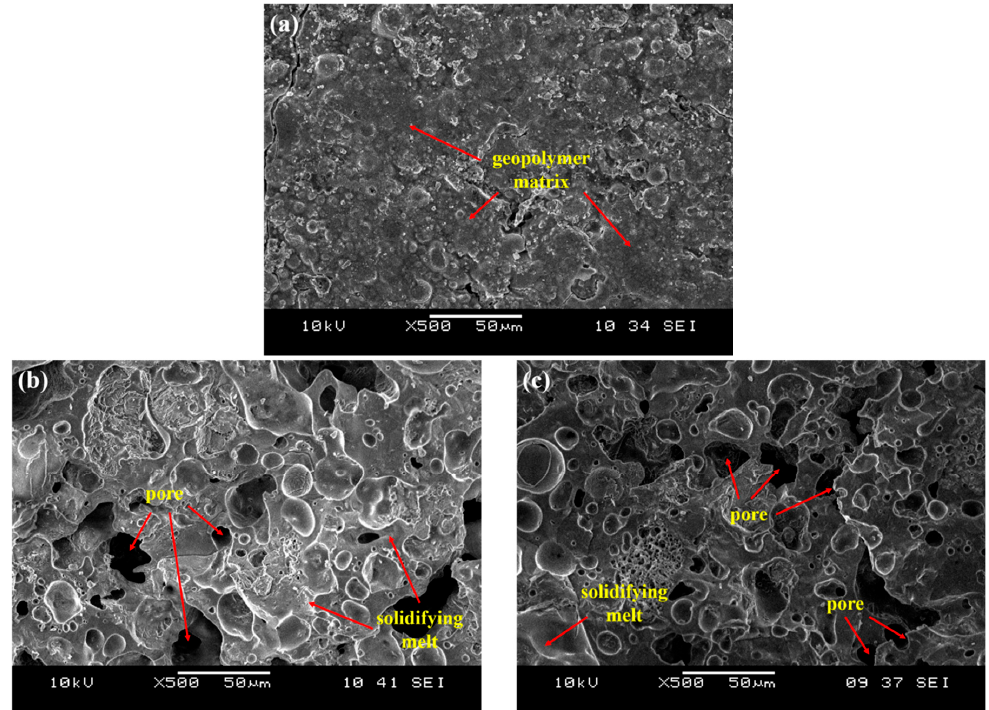
Figure 13. SEM micrographs of fly ash geopolymers with ( a ) 2% of silica fume addition after exposed to 200 °C, ( b ) 2% and ( c ) 4% of silica fume addition after exposed to 1000 °C.